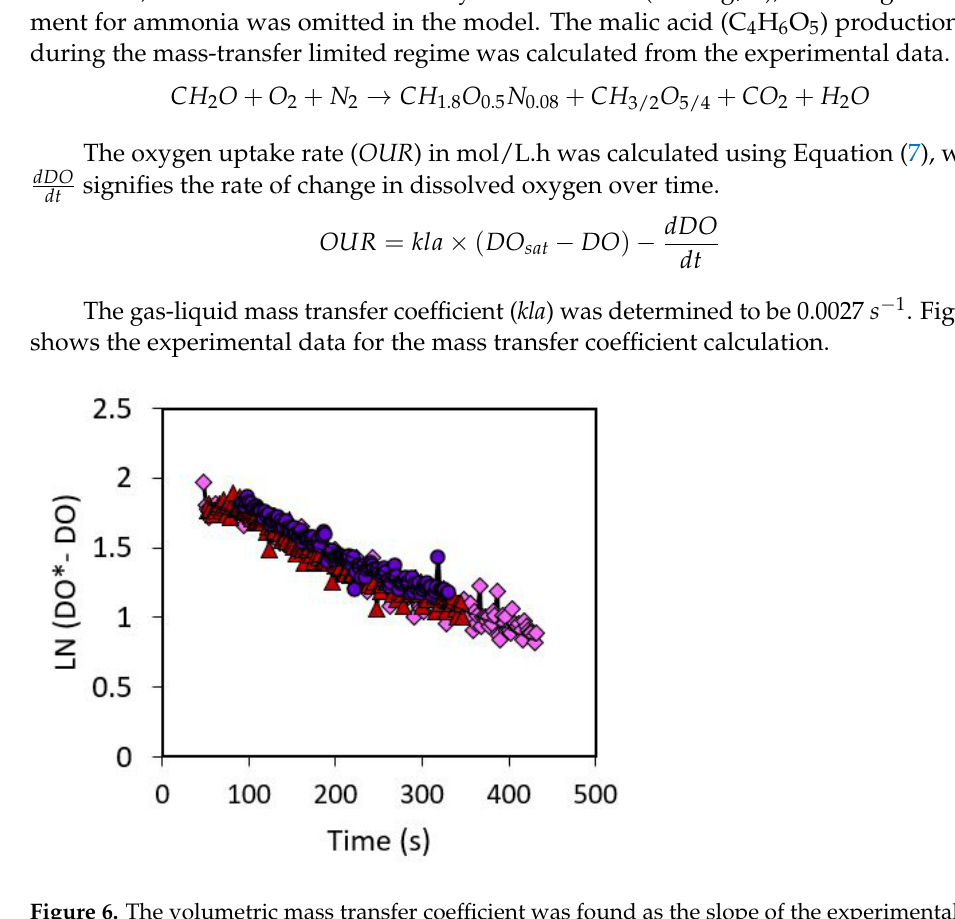
Figure 6. The volumetric mass transfer coefficient was found as the slope of the experimental data. Repeatable data was